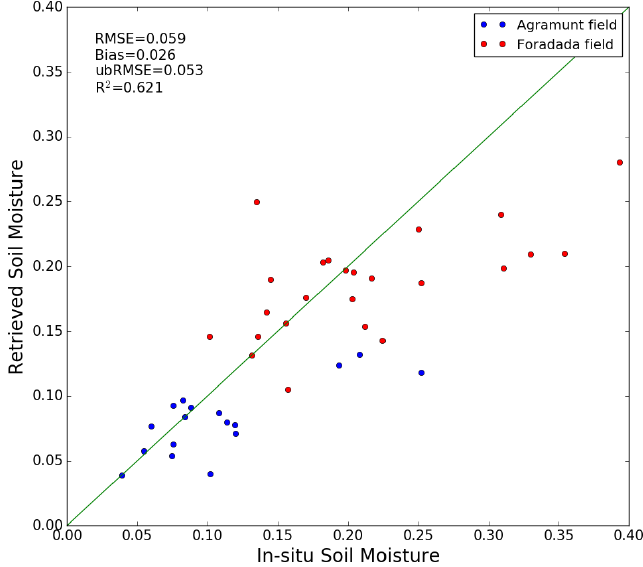
Figure 10. Intercomparison between ground measurements in the two demonstration fields of Agramunt and Foradada and S1 moisture estimations based on method 2.